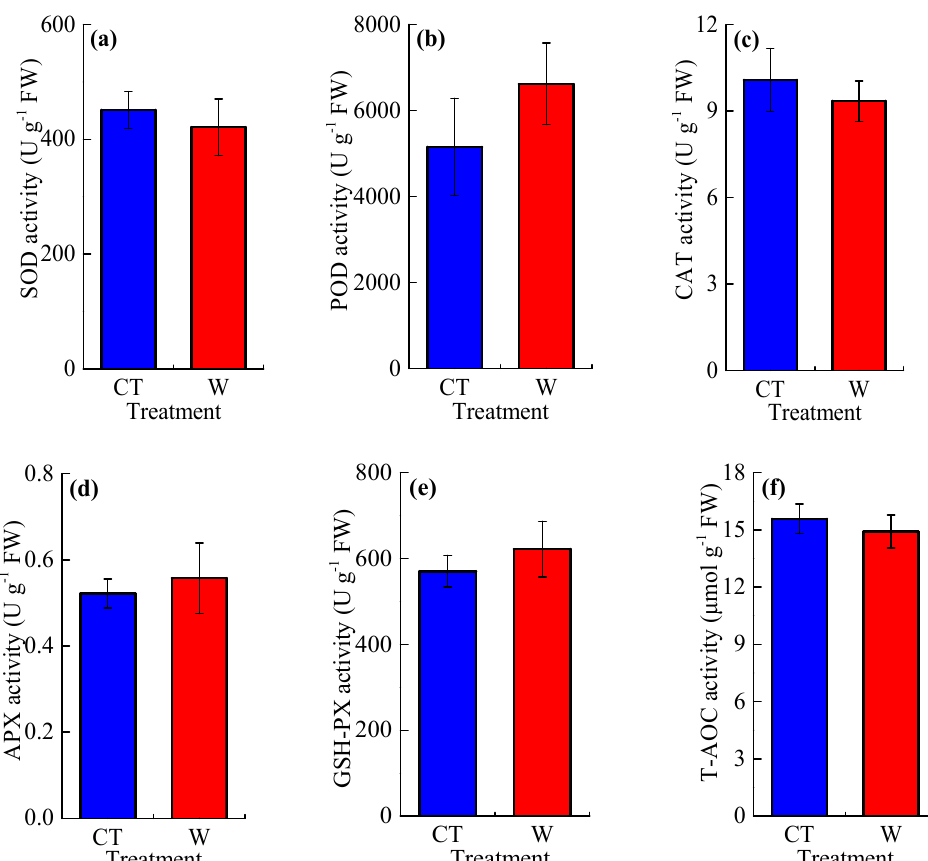
Figure 2. The activities of antioxidant enzymes in Cunninghamia lanceolata under the control (CT) and warming (W) treatments (mean ± standard deviation, n = 5 replicates each). ( a ) Superoxide dismutase (SOD), ( b ) peroxidase (POD), ( c ) catalase (CAT), ( d ) ascorbate peroxidase (APX), ( e ) glutathione peroxidase (GSH-PX), ( f ) total antioxidant capacity (T-AOC).